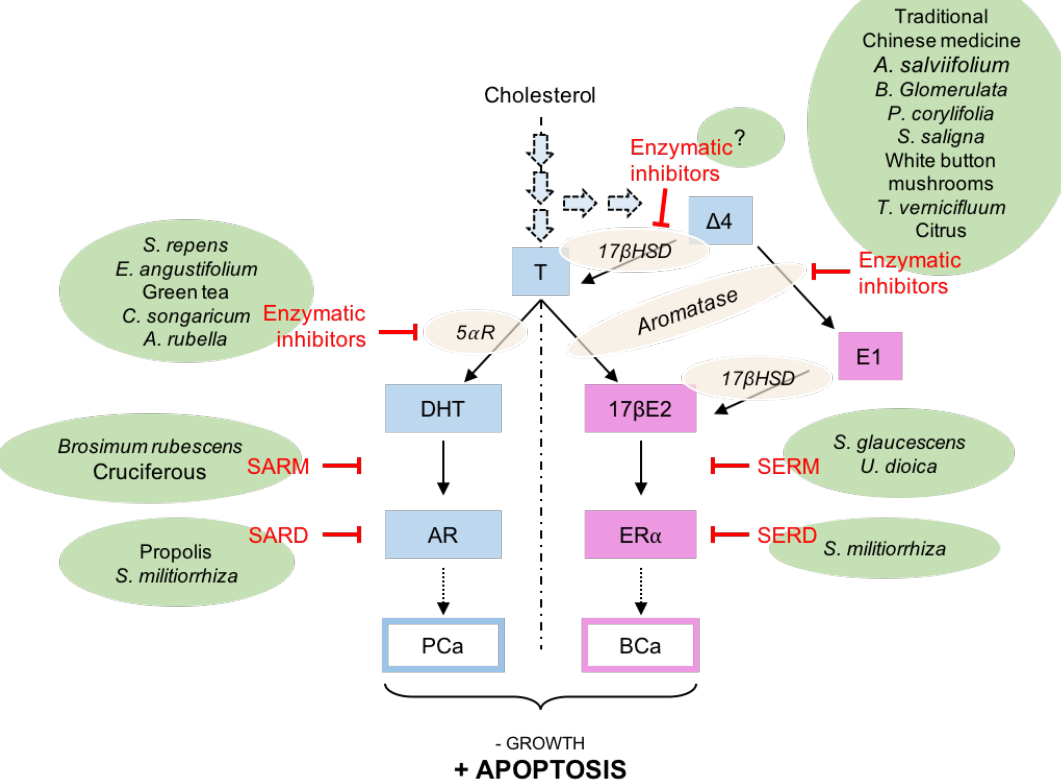
Figure 2. Examples and sites of activity of natural extracts that could modulate androgen and estrogen receptor activities in prostate (PCa) or breast (BCa) cancer. For more information regarding the isolated molecules that show a significant activity, refer to the main text. ∆ 4, ∆ 4-androstenedione; 5 α R, 5 α -reductase; 17 β E2, estradiol; 17 β HSD, 17 β -hydroxysteroid dehydrogenase; AR, androgen receptor; BCa, breast cancer; E1, estrone; ER α , estrogen receptor α ; PCa, prostate cancer; SARM, specific androgen receptor modulator; SARD, specific androgen receptor degrader / down-regulator; SERM, specific estrogen receptor modulator; SERD, specific estrogen receptor degrader / down-regulator; T, testosterone.